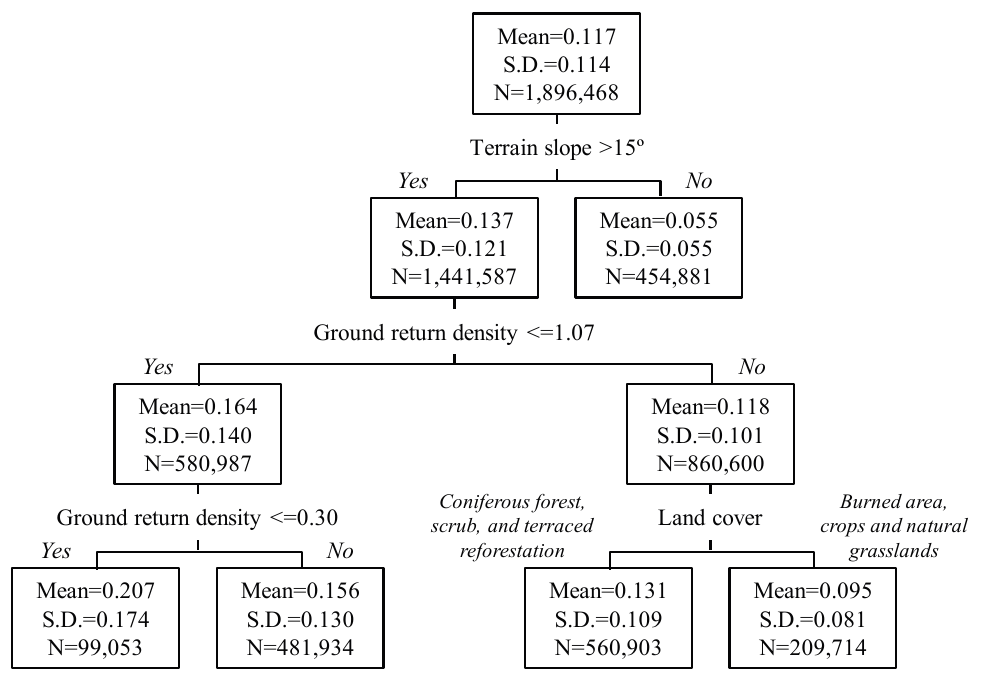
Figure 3. Classification tree resulting from CART analysis of absolute errors for a 1 m resolution DEM created using TIN to raster interpolation. Each node (square) is labeled with average absolute error ( Mean ), standard deviation ( S.D .) and the number ( N ) of points in that group. The model is read from top down until terminal nodes predicting the vertical error from selected variables appear.